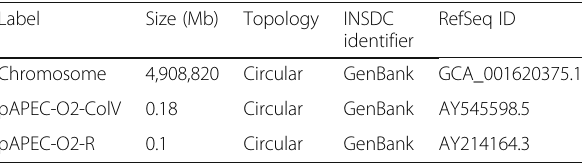
Table 3 Summary of APEC_O2 genome: one chromosome and two plasmids